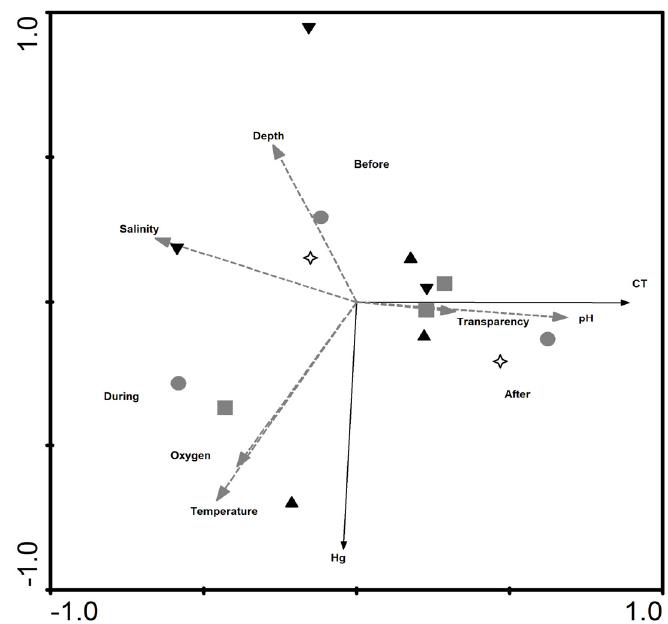
Figure 5. RDA performed using abiotic data (Depth, salinity, oxygen, transparency, pH, temperature), Hg concentrations and lengths (CT) in swimming crab taking into account mainly sample points and secondarily the period of dredging, dividing in before, during and after. Black symbols represent the more internal (Paquetá) and external areas (Urca), while gray indicates the other sampling points, ▲ , Urca Beach; ■ , Flamengo Beach; ● , Engenho; +, seaport; ▼ , Paquetá.